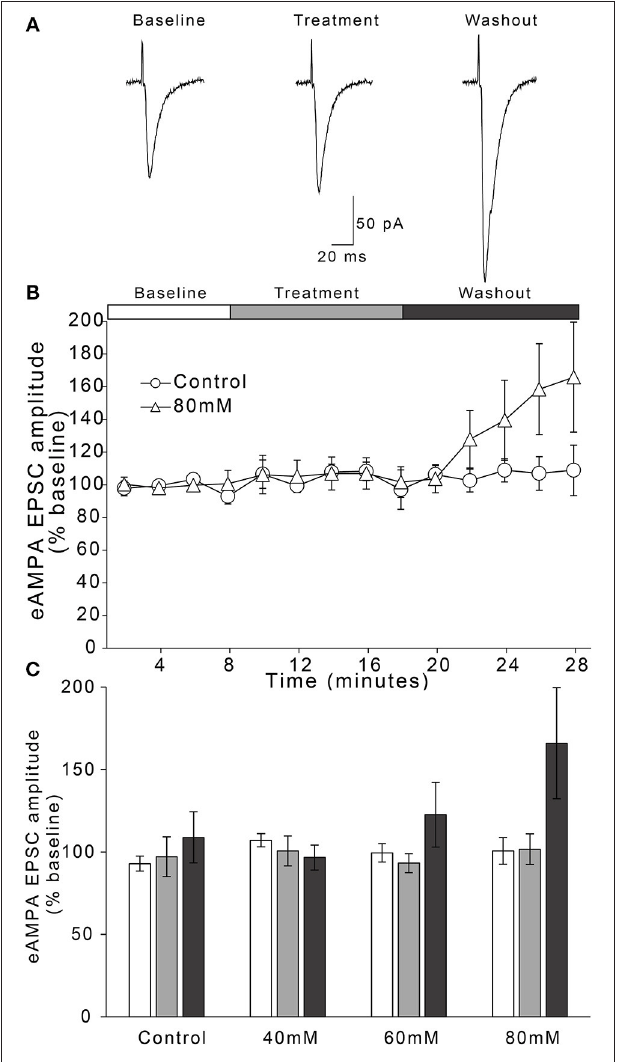
FIGURE 3 | Ethanol has no effect on evoked AMPAR-mediated EPSC amplitudes in AIC layer 2/3 pyramidal neurons. (A) Representative traces from a single neuron showing evoked AMPAR-mediated EPSCs before and after treatment with acute ethanol (80mM). (B) Normalized timecourse of evoked AMPAR EPSC (eAMPA) responses in either sham solution exchange (open circles) or 80mM ethanol application (open triangles) conditions. The white bar displays the 8min baseline period, the gray bar displays the 10min treatment period, and the dark gray bar shows the 10min washout period. (C) Bars show average eAMPA amplitudes during the last 2min of each period of the experiment (Baseline, Treatment, and Washout), expressed as a percentage of the entire 8min baseline average. Values are expressed as averages ± S.E.M (Control, n = 4 neurons/4 slices/3 mice; 40mM, n = 6 neurons/6 slices/4 mice; 60mM, n = 5 neurons/5 slices/4 mice; 80mM, n = 9 neurons/9 slices/7 mice).